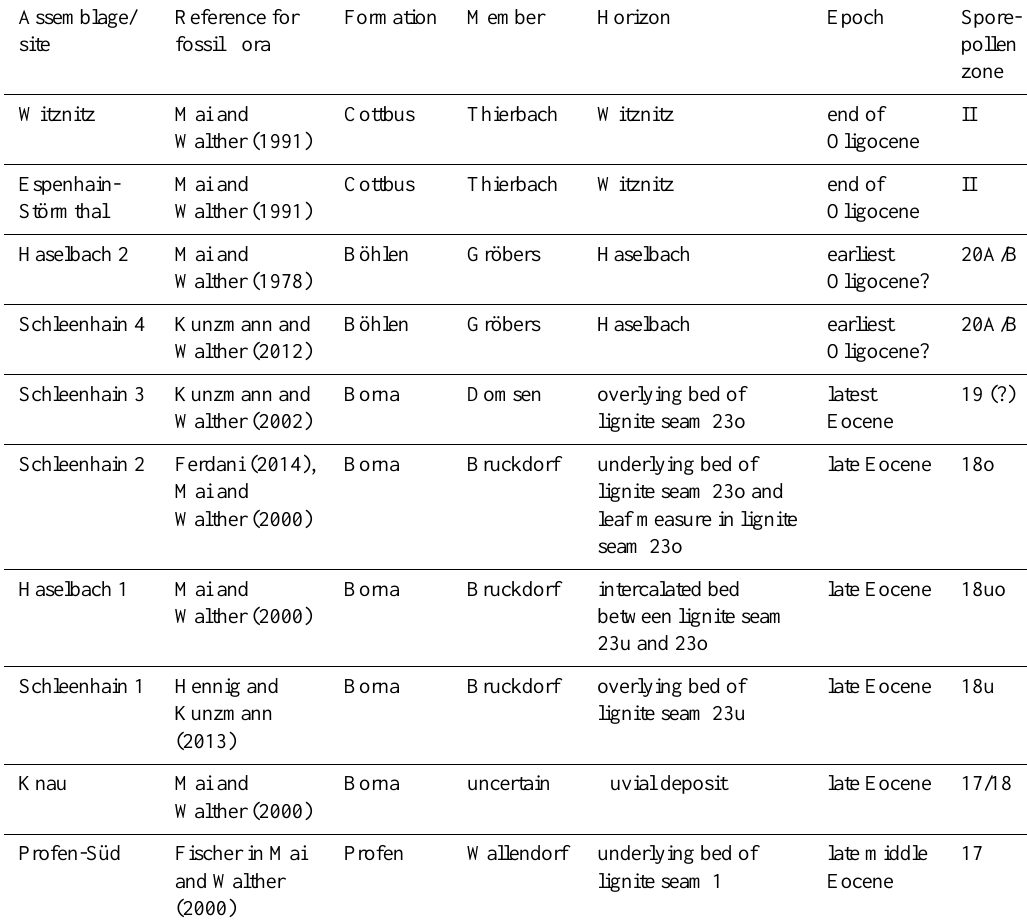
Table 1. Lithostratigraphic and phytostratigraphic positions of the Eotrigonobalanus furcinervis -containing fossil taphocoenoses in the Weißelster Basin (central Germany); lithostratigraphy after Standke et al. (2010), spore-pollen zonation after Krutzsch